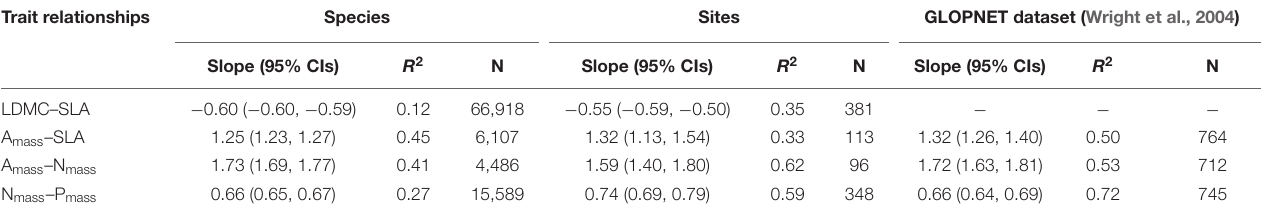
TABLE 4 | Comparison of leaf trait relationships on a global scale. Trait relationships Species